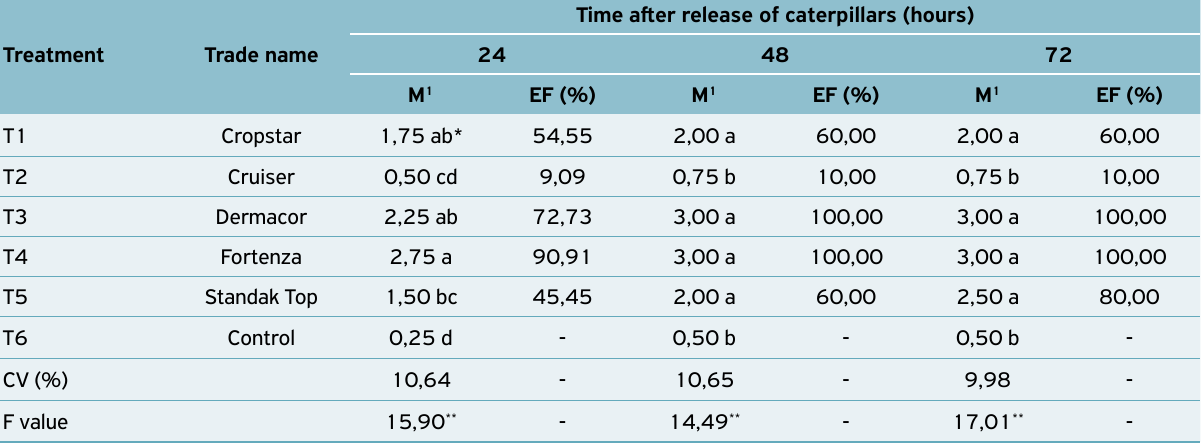
Figure 2. Effect of seed treatment with insecticides on the percentage of leaf area consumed by third instar Spodoptera frugiperda larvae (Coefficient of Variation in %: 13.73; Least significant difference: Table 2. Mortality and control efficiency (%) of insecticides applied in the seed treatment against Spodoptera frugiperda one, two, and three days after caterpillar release among soybean plants.